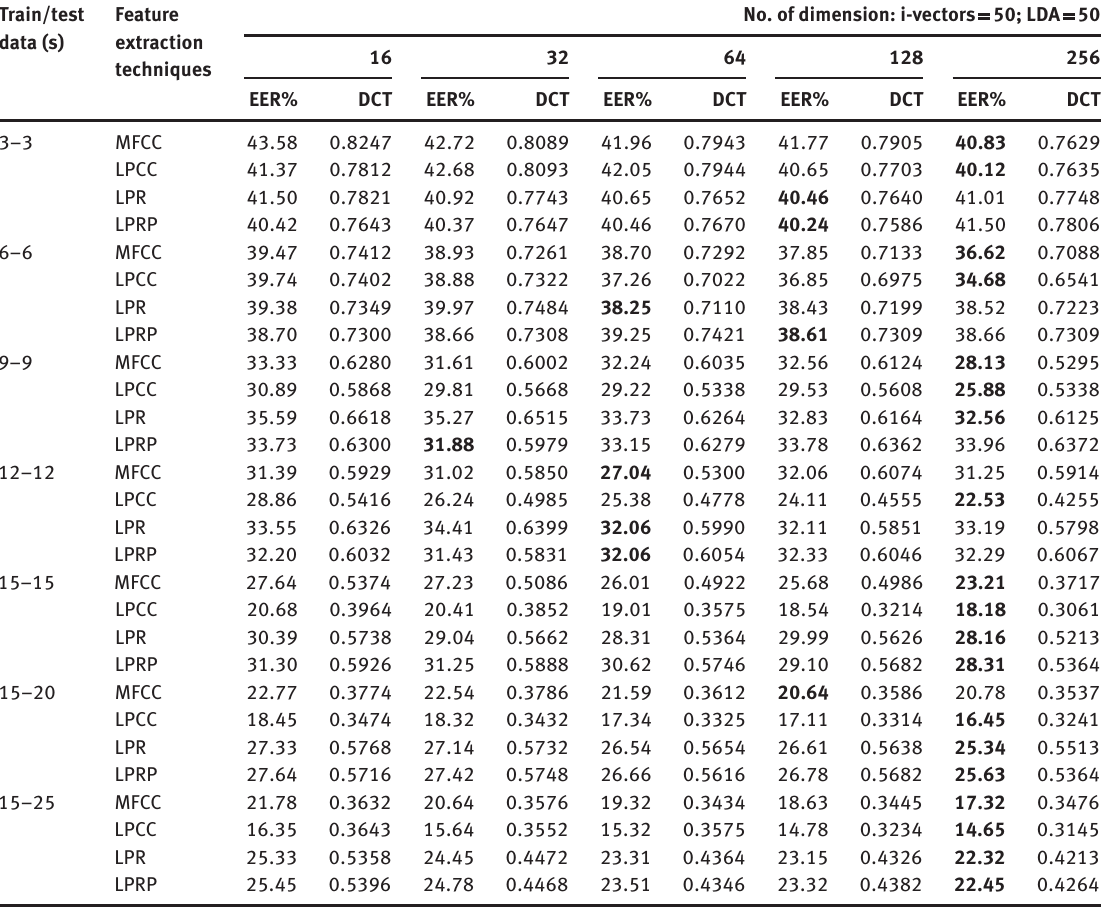
Table 3: EER of Speaker Verification for Using NIST 2003 Database for Different Feature Extraction Techniques (13 Dimensions) and Modeling Done by i-Vectors.